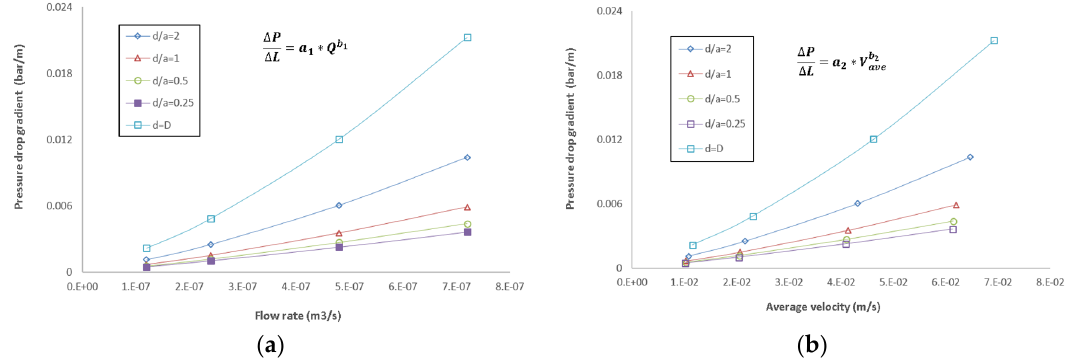
Figure 6. The pressure drop, associated with the connecting filament diameter, as a function of ( a ) the flow rate and ( b ) the average velocity. Table 1. The pressure drop function parameters.